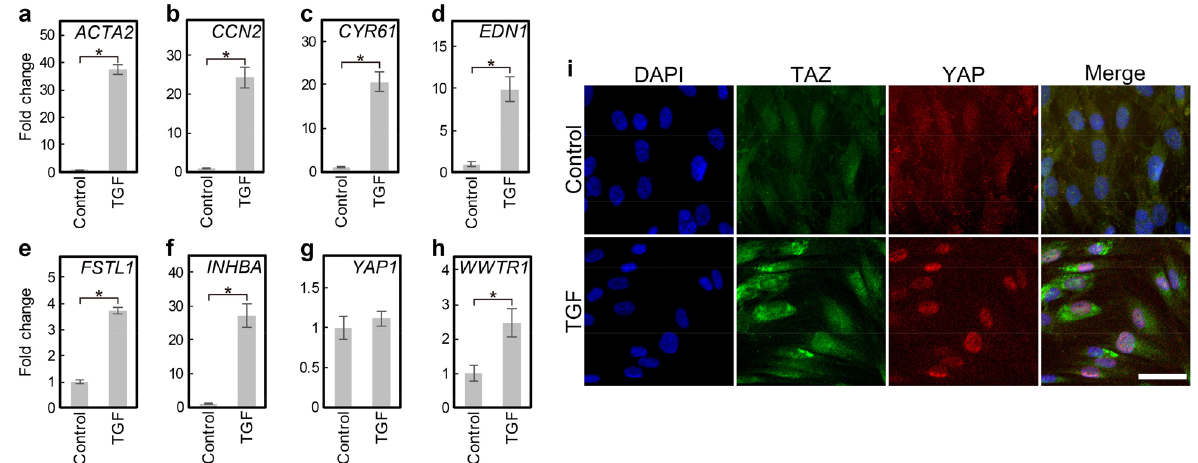
Figure 2. TGF-β1 activated YAP/TAZ in HVOX. HVOX fibroblasts were treated with or without 10 ng/mL TGF-β1 for 24 h. Expression of ACTA2 ( a ), target genes of YAP/TAZ ( b , CCN2 ; c CYR61 ; d EDN1 ; e FSTL1 ; f INHBA ), YAP1 ( g ), and WWTR1 ( h ) were analyzed by qPCR (Data shown as mean ± SD; n = 3; * p < 0.05, Student’s t -test). YAP/TAZ nuclear localization was examined by immunostaining ( i ; bar = 50 µm).